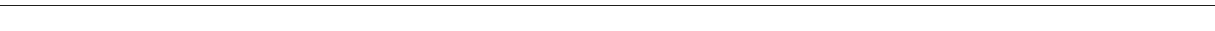
Fig. 6 IL-23A expression is increased in N-WASP- null keratinocytes. a qRT-PCR analysis of indicated genes in FACS puri fi ed primary keratinocytes from 6- week-old mice ( n : 4/4/4, mean ± SD, two-tailed unpaired t -test, 2 independent sorting). b qRT-PCR analysis of indicated cytokine mRNA expression in primary keratinocytes. All normalized to GAPDH ( n : 3/3, mean ± SD, two-tailed unpaired t -test). c Primary keratinocytes were differentiated with 2 mM CaCl 2 (High Ca 2 + ) for 48 h and then analyzed by qRT-PCR for IL-23A expression, compared to untreated cells (Low Ca 2 + ; n : 3/3, mean ± SD, two-tailed unpaired t -test). d qRT-PCR analysis of IL-23A mRNA expression in primary keratinocytes in response to 24 h treatment with indicated inhibitors. All normalized to GAPDH ( n : 3/3, mean ± SD, two-tailed unpaired t -test). e Representative immuno fl uorescence of phalloidin in con and ko back skin. Scale bar: 100 µ m. f Quanti fi cation of FACS mean fl uorescence intensity of phalloidin in con and ko primary keratinocyte ( n : 3/3, mean ± SD, two-tailed unpaired t -test). g qRT-PCR analysis of IL-23A mRNA expression in primary keratinocytes treated with indicated inhibitors for 24 h. All normalized to GAPDH. The right panel shows the same data, but normalized to the respective DMSO-treated samples, thus showing the relative effect of the treatment as fold change ( n : 3/3, mean ± SD, two-tailed unpaired t -test; * p ≤ 0.05; ** p ≤ 0.01; *** p ≤ 0.001; **** p ≤